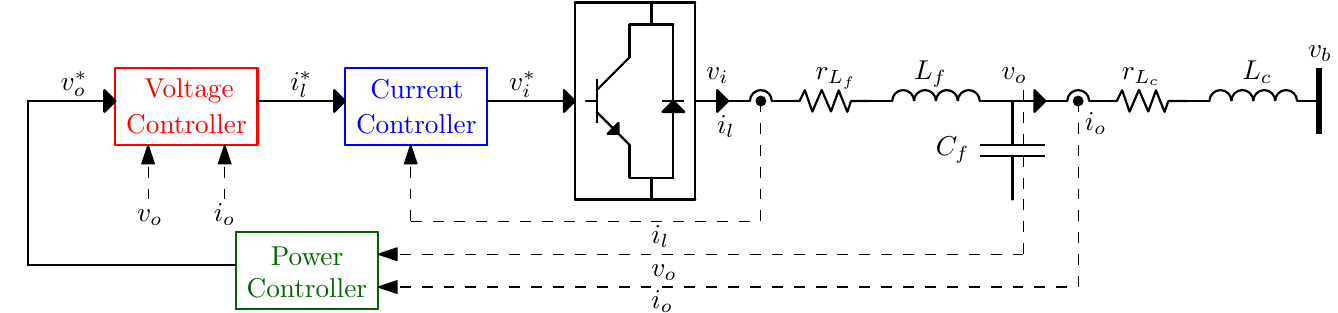
Figure 1. The control schematic diagram of an islanded